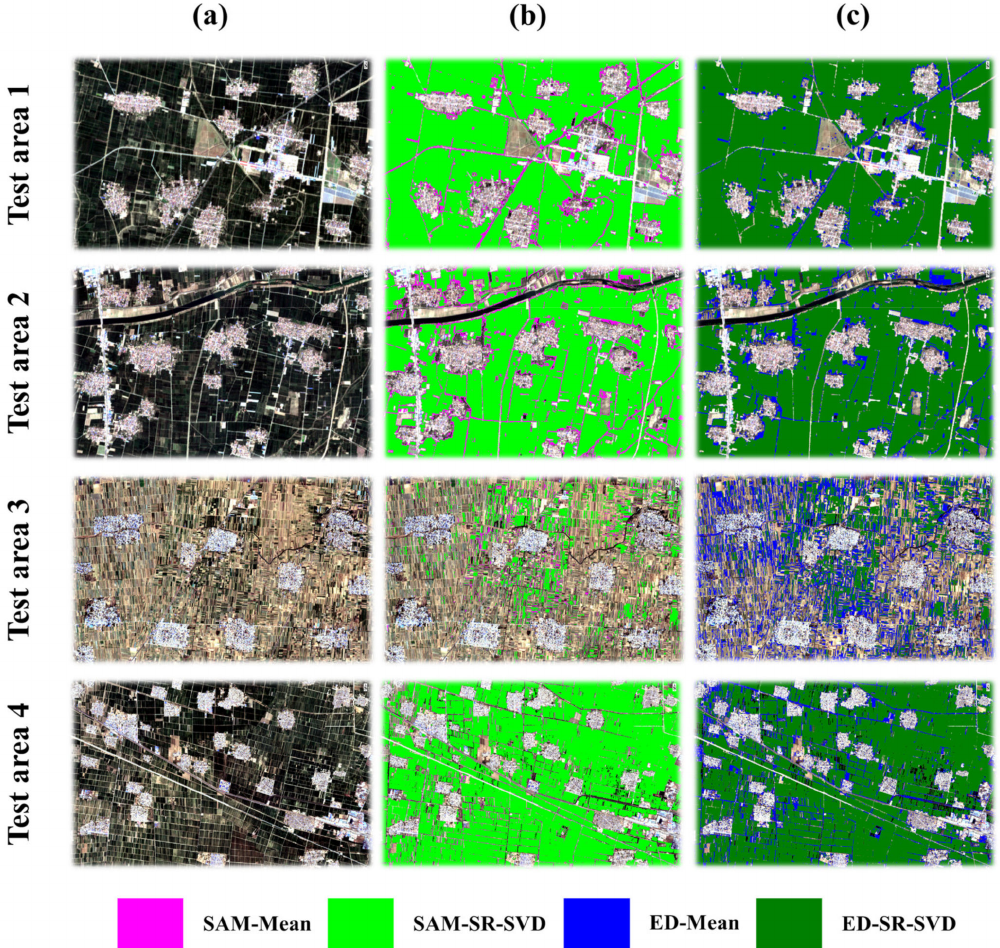
Figure 8. Winter wheat mapping results and overlay analysis based on different methods. Test area 1–2 is selected from Puyang County, and test area 3–4 is from Shenzhou City. ( a ) Sentinel-2 image (RGB: band 4, 3, 2, 8 April 2018), ( b ) comparison of SAM-based mapping results, ( c ) comparison of ED-based mapping